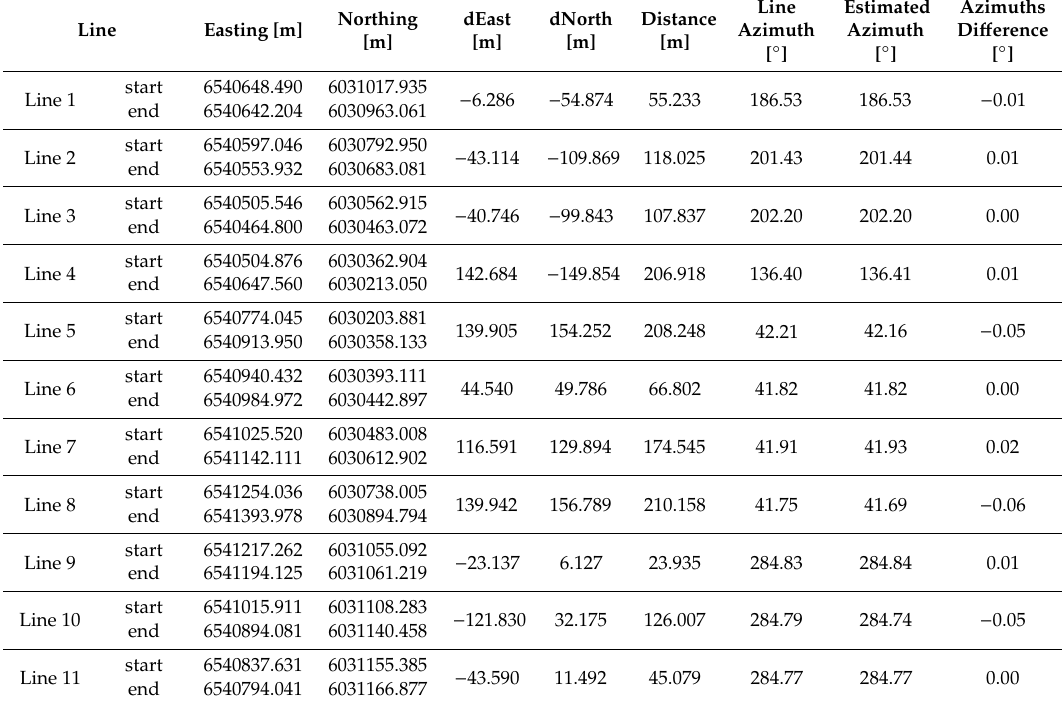
Table 5. Results of the second control analysis of the azimuth value.